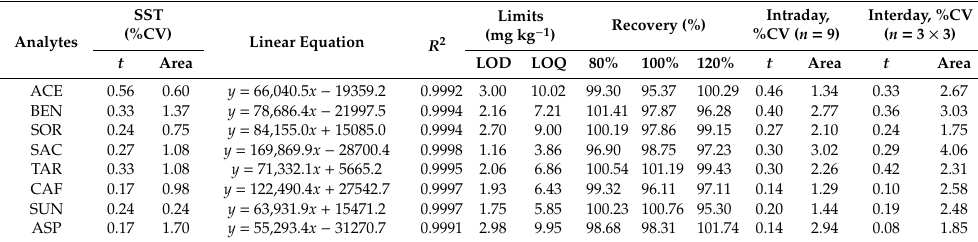
Table 4. Analytical properties for the validated HPLC-DAD